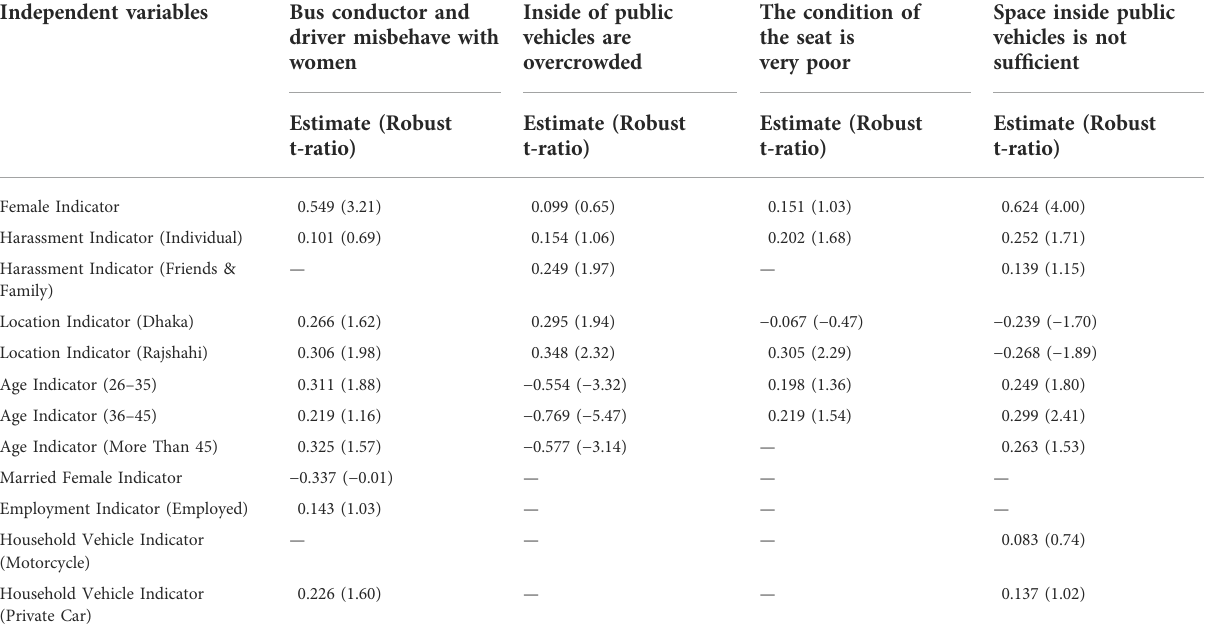
TABLE 4 Ordered probit model results on the experience of using public